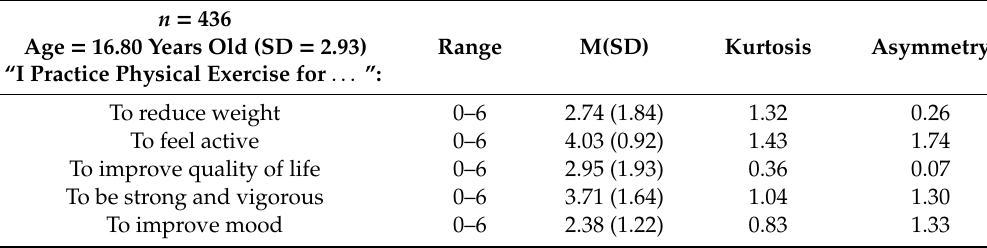
Table 1. Descriptive statistics and variance of reasons for the practice of physical exercise. n = 436 Age = 16.80 Years Old (SD =